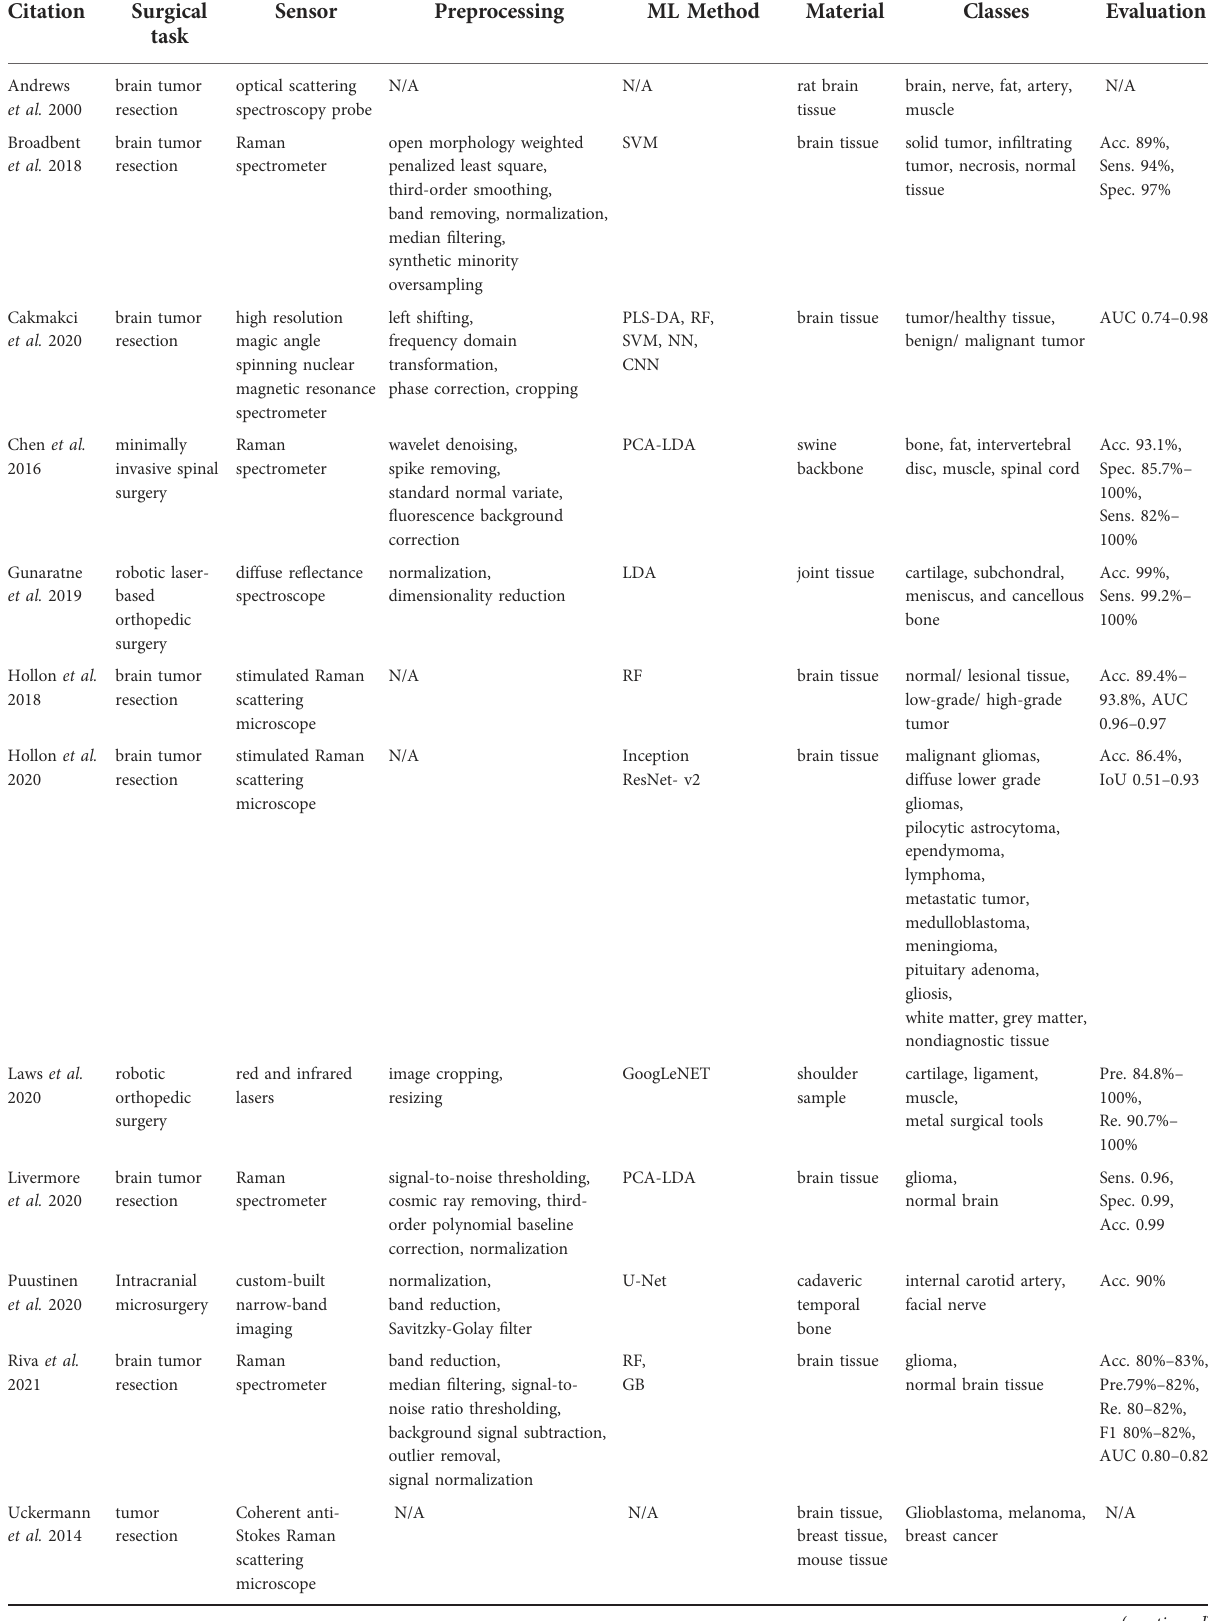
TABLE 3 General descriptions of selected studies on